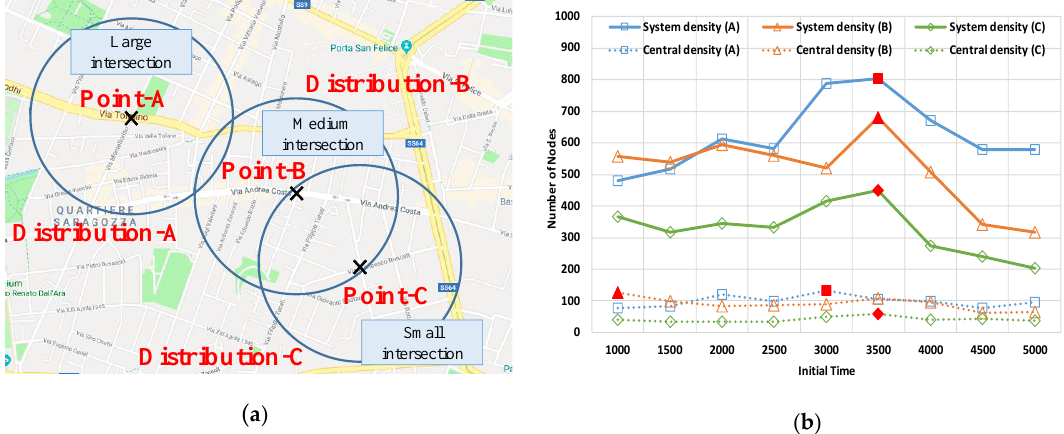
Figure 8. The three extracted intersections (A—C) and the statistic information about system density and central density. ( a ) Location and size of the three intersections (A—C); ( b ) The system density and central density in three intersections (A—C).